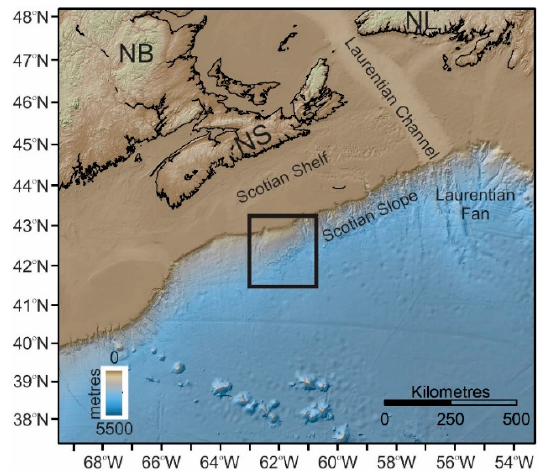
Figure 1. Study area (black rectangle) location on the Scotian Slope off eastern Canada. Nova Scotia (NS), Newfoundland and Labrador (NL), and New Brunswick (NB). North is to the top of the map.